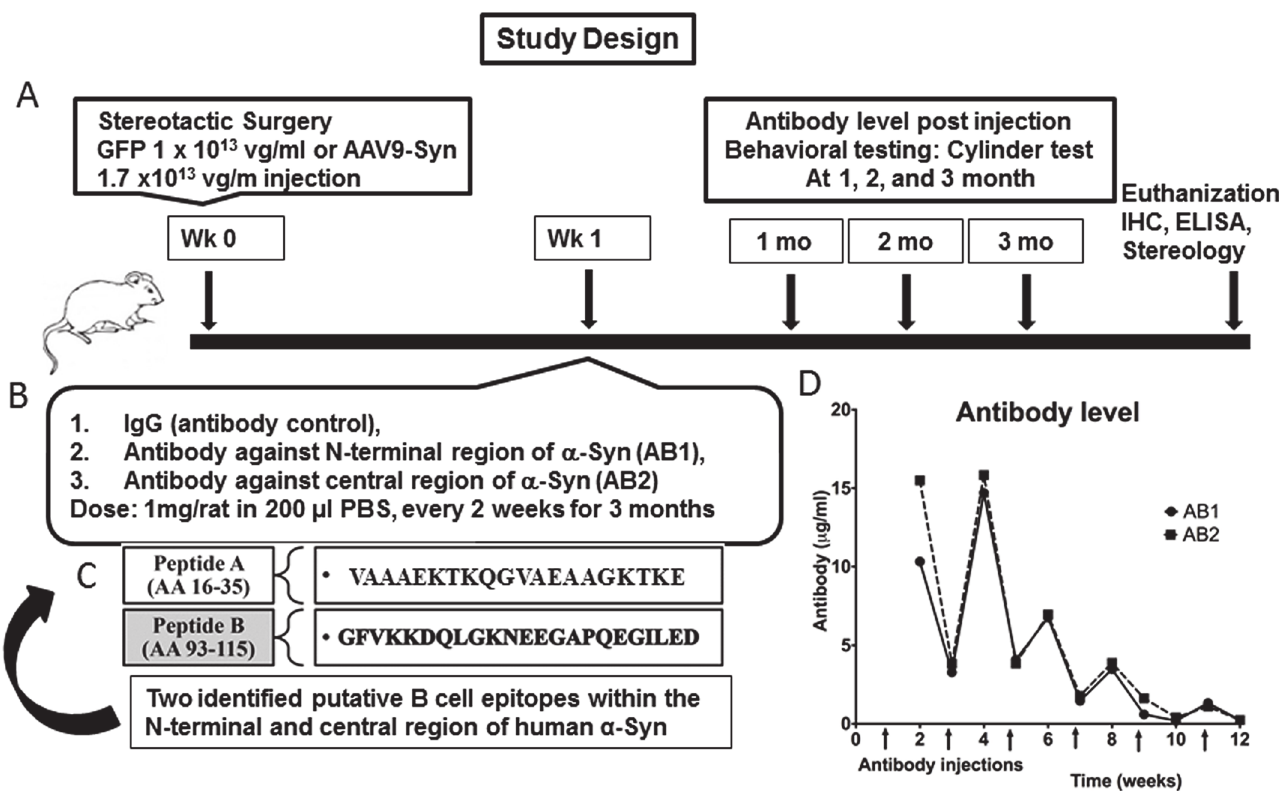
Fig 1. Study design to test the efficacy of anti- α -Syn antibody in rat AAV- α -Syn PD model. A schematic diagram depicting (A) the details on AAV9 concentrations used and the time frame for AAV-9 injections and the behavioral testing, (B) the timing of the first antibody injections and initial dose, as indicated in the methods section the dose of the AB injected was reduced over time (C) the sequence of the antibodies and (D) level of serum antibodies taken 1 week after injections and just before subsequent injections. This demonstrates that antibody levels remained high for the first month and then clearance increased after 6 weeks. Times of injections are indicated by the arrows on the bottom of the